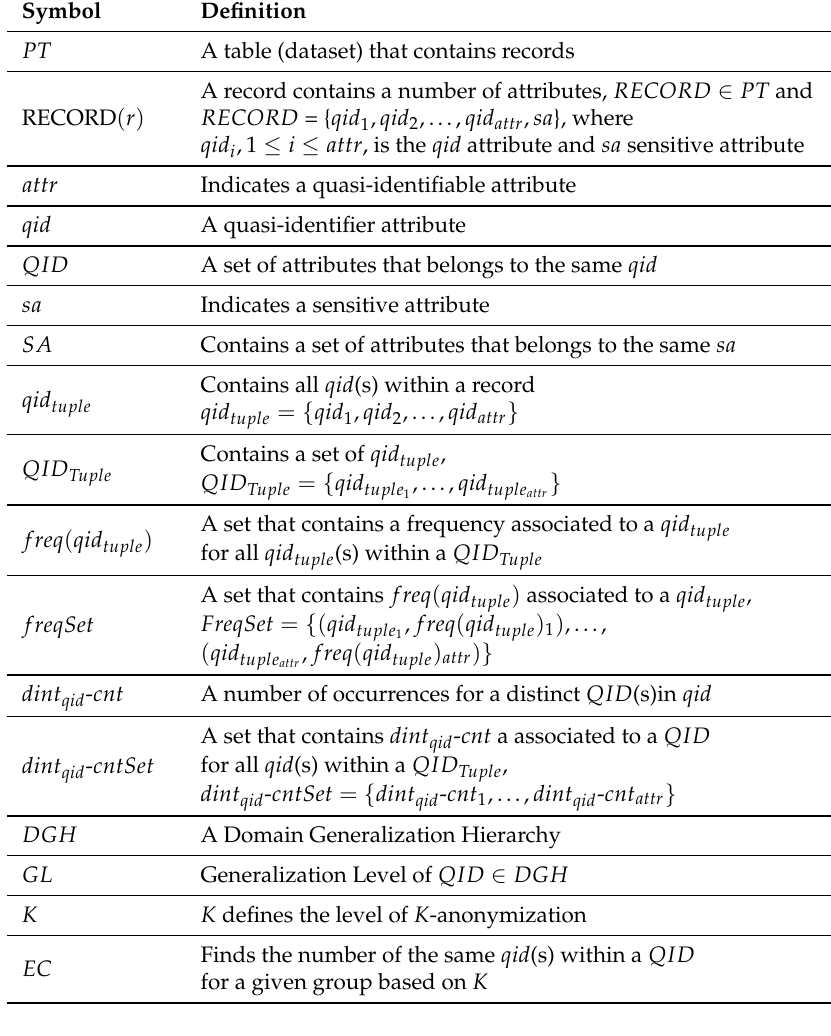
Table 2. Basic Symbols and Notations.